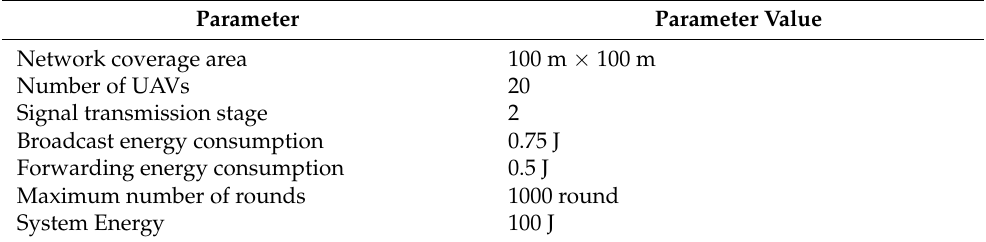
Table 3. Experimental parameter setting.